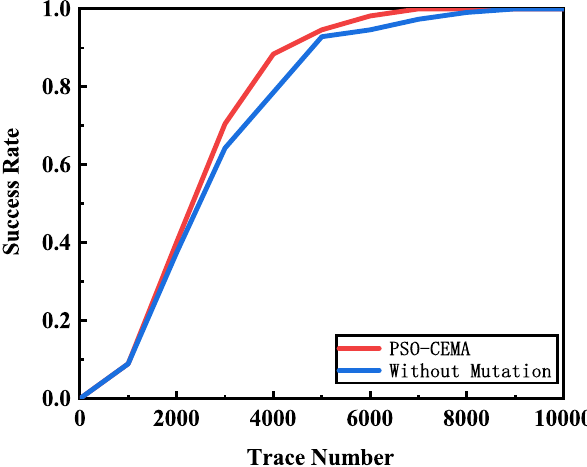
Figure 7. Success rate comparison of PSO-CEMA with or without mutation operation.